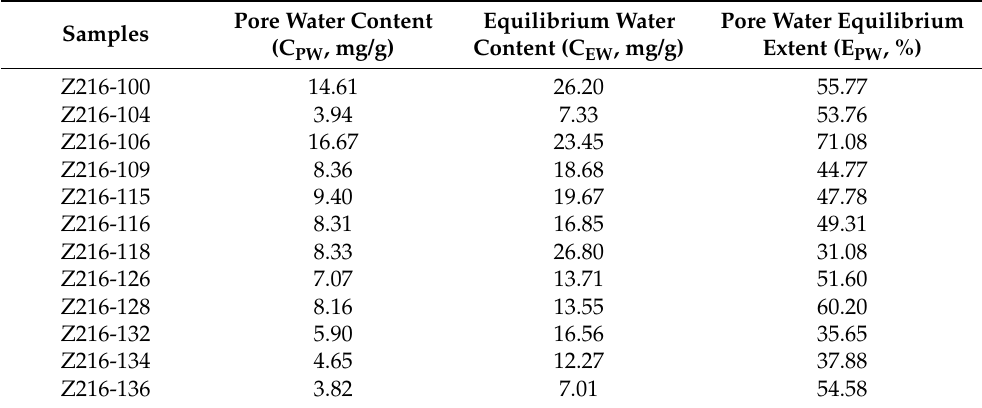
Table 2. Water-bearing properties of the studied shale samples in the Luzhou Block.